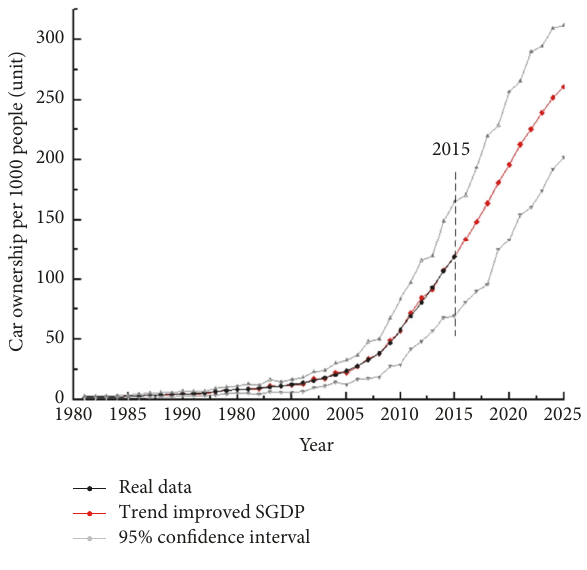
Figure 7: Projection of vehicle ownership per 1000 people to 2025 in China.